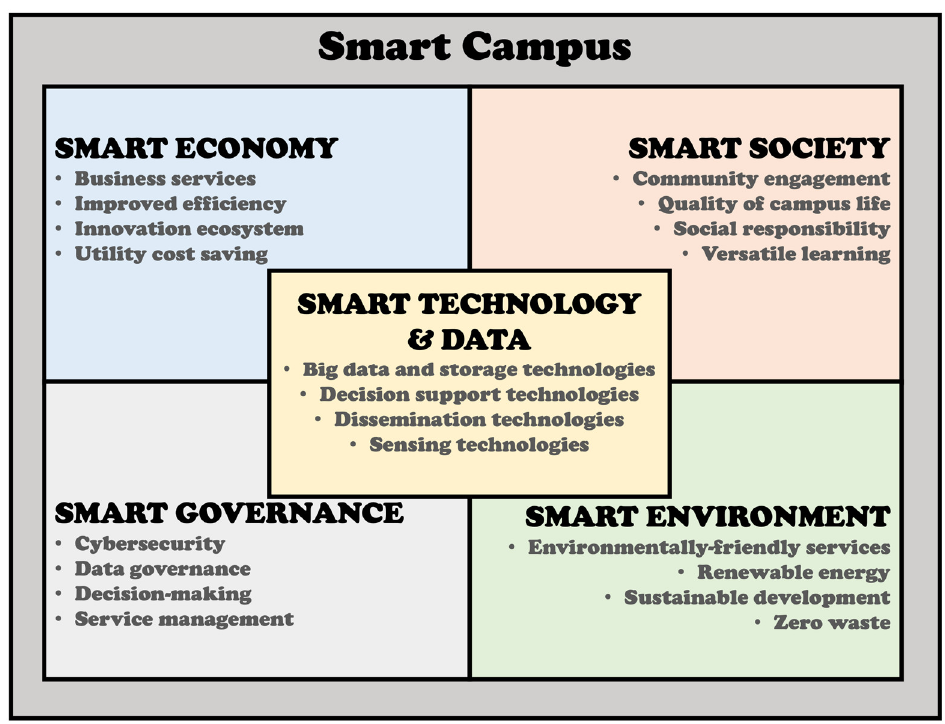
Figure 3. Conceptual framework of smart campus.